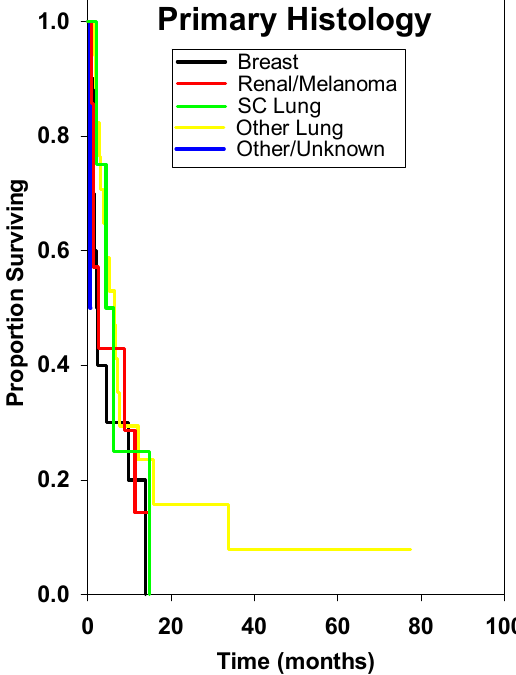
Figure 2. Survival curves subdivided by primary tumor histology. There was no statistical difference among these groups. See Table 1 for sample size.